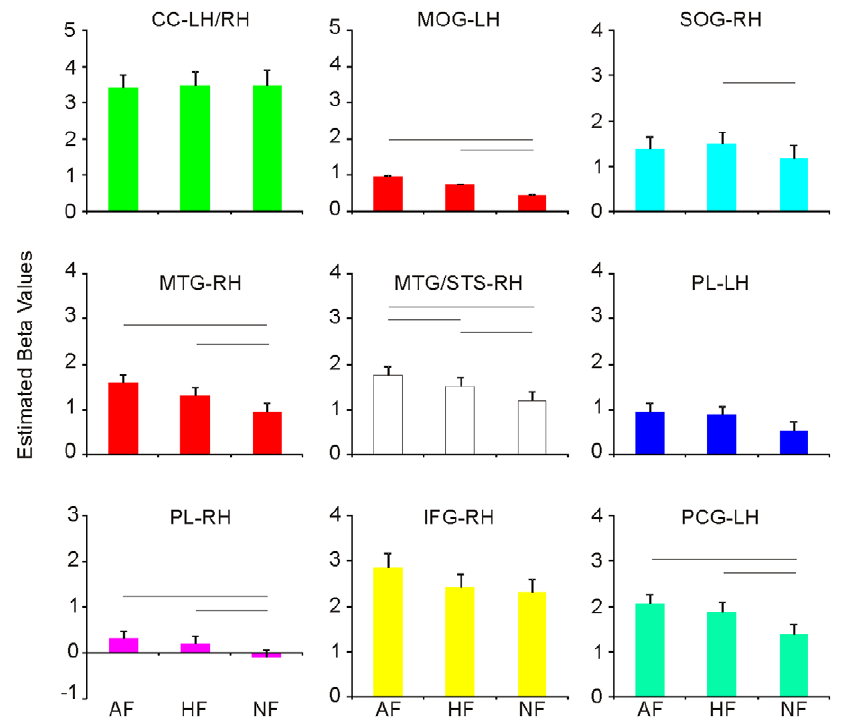
Figure 3. Estimated beta values for the E conditions.